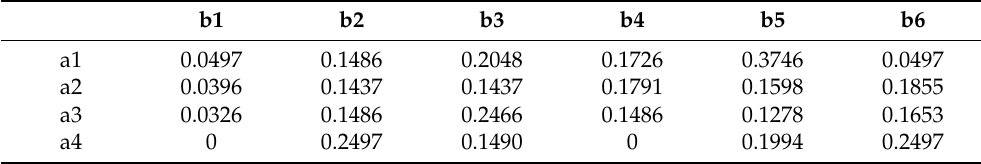
Table 5. Attribute weight matrix.